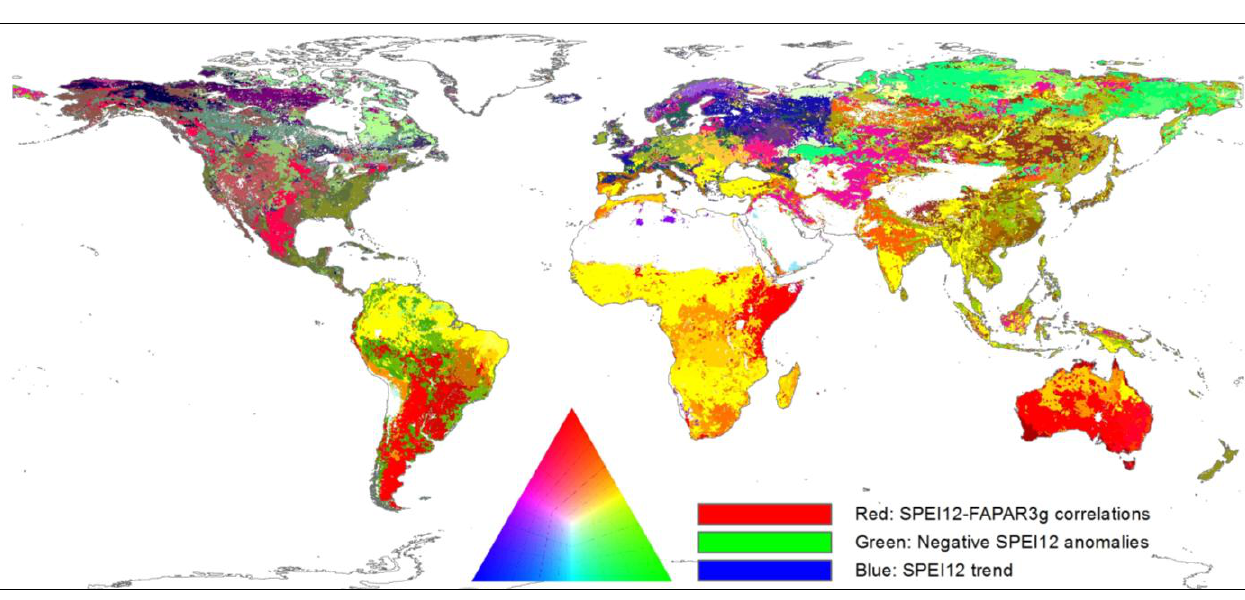
Figure 2. RGB color composite of SPEI12-FPAR3g correlation ( red ), SPEI12 trend ( green ) and negative SPEI12 anomalies ( blue ) of the ERTs. Similar tones indicate ERTs with similar vegetation response to SPEI12 anomalies between 1982 and